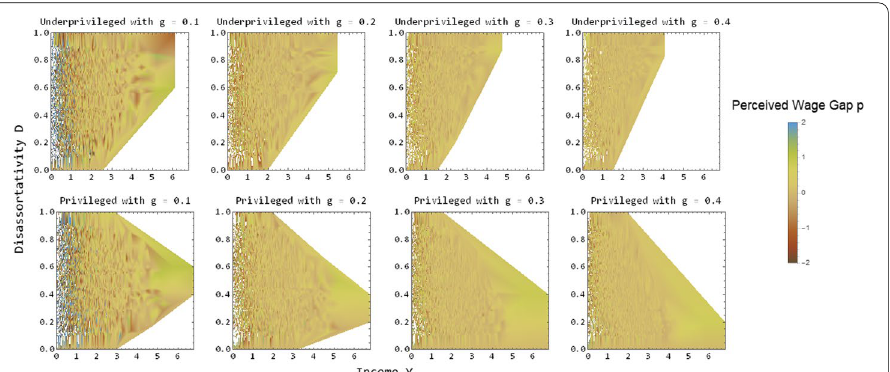
Fig. 4 Heatmap of wage gap perceptions (as a ratio to the correct wage gap g ) for varying privilege, disassortativity D (rate of links to the other privilege class) and income Y for ρ = 8 and varying actual wage gaps g ∈ { 0.1 ; 0.2 ; 0.3 ; 0.4 } . Upper panels for the underprivileged agents, lower panels for the privileged ones